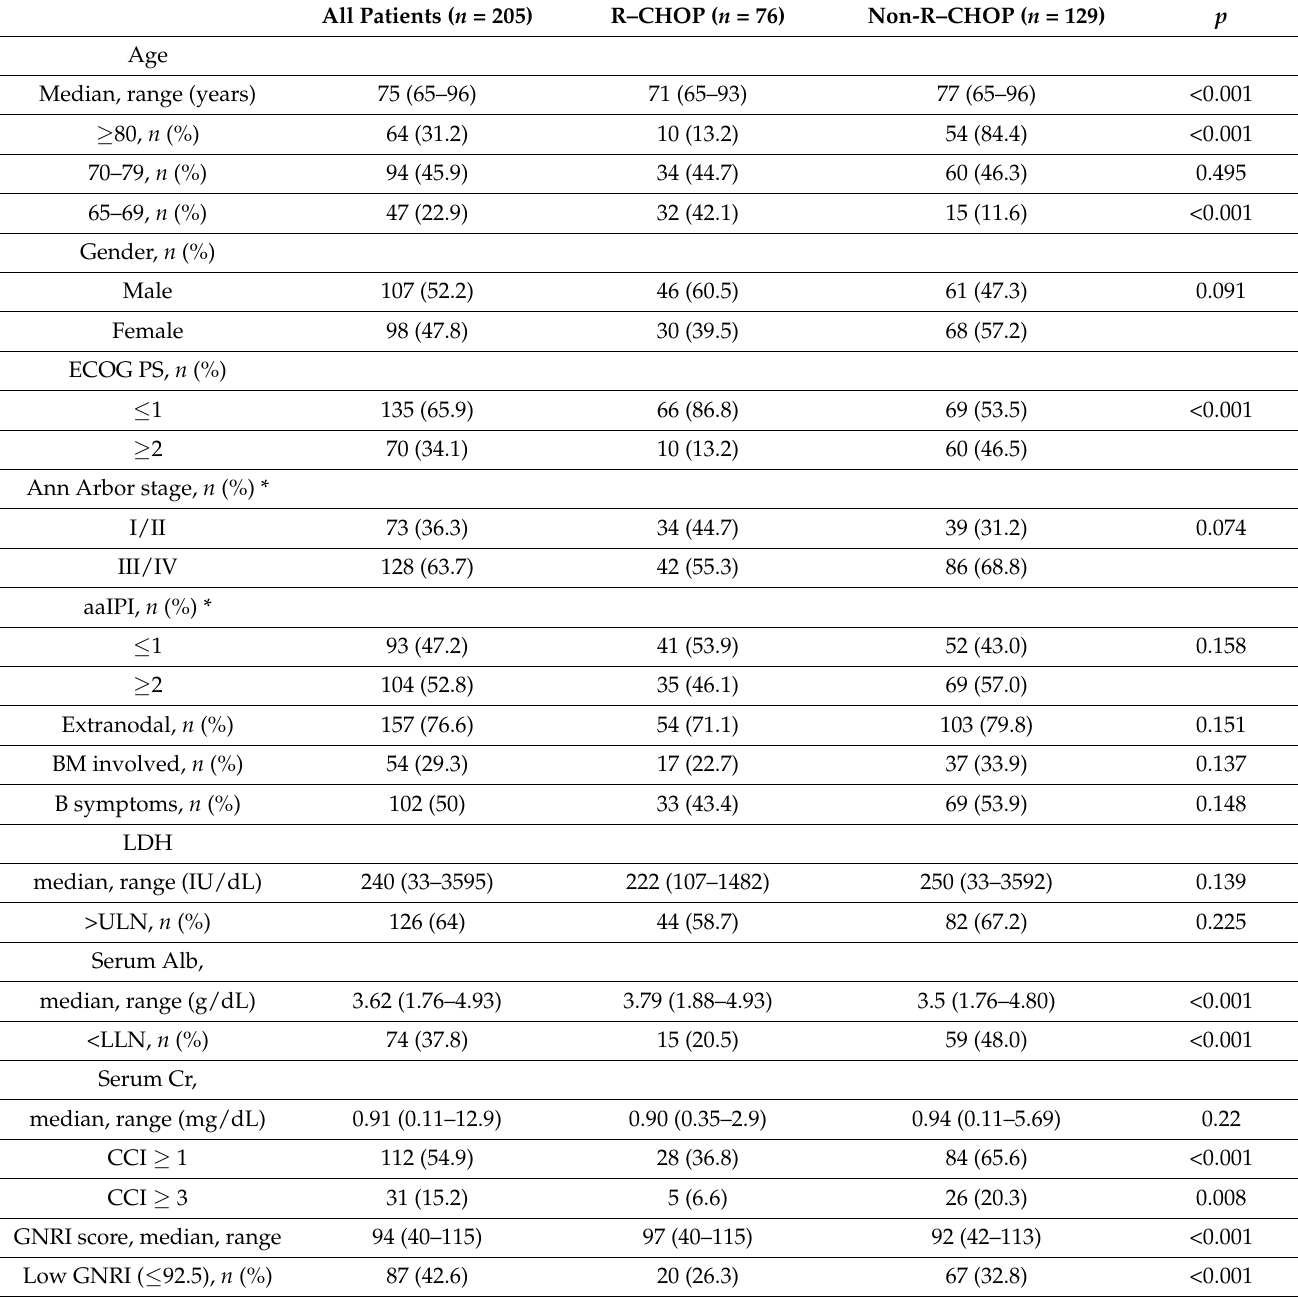
Table 1. Baseline characteristics of DLBCL patients according to the treatment